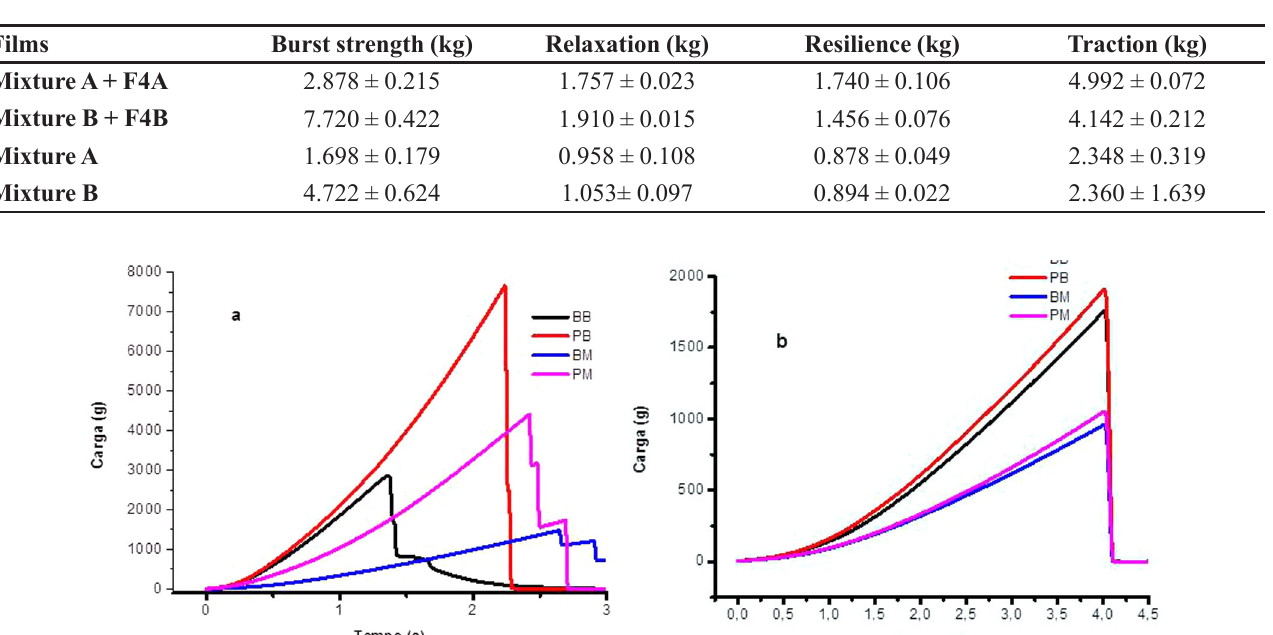
TABLE IV – Values (means ± SD) obtained for bilayer films (with and without bupropion) and monolayer (with and without bupropion), subjected to strength